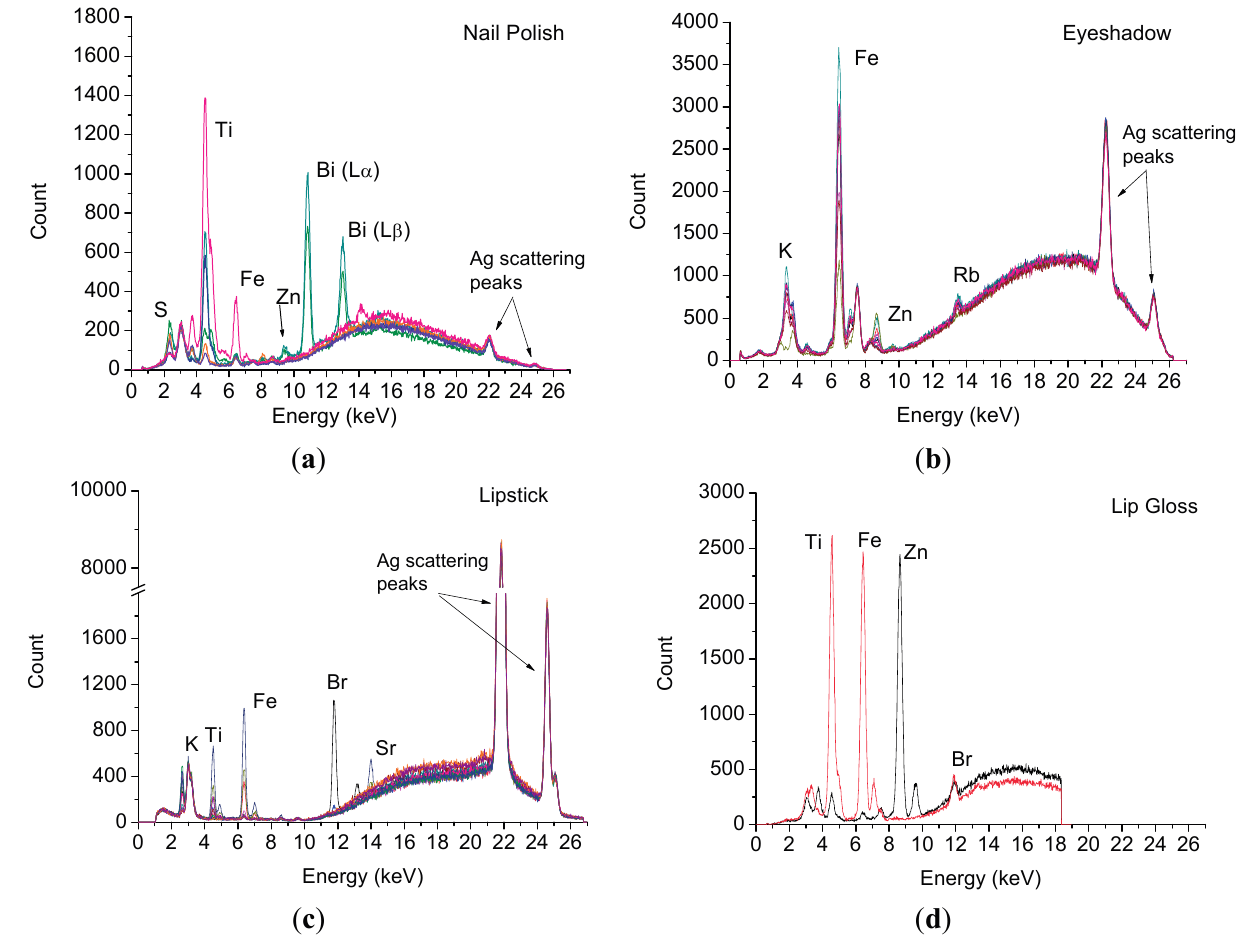
Figure 1. Overlapped Energy Dispersive X-ray Fluorescence (EDXRF) spectra of different cosmetic matrix ( a ) six spectra of nail polishes, ( b ) nine spectra of eye shadow, ( c ) 12 spectra of lipstick, ( d ) two spectra of lip